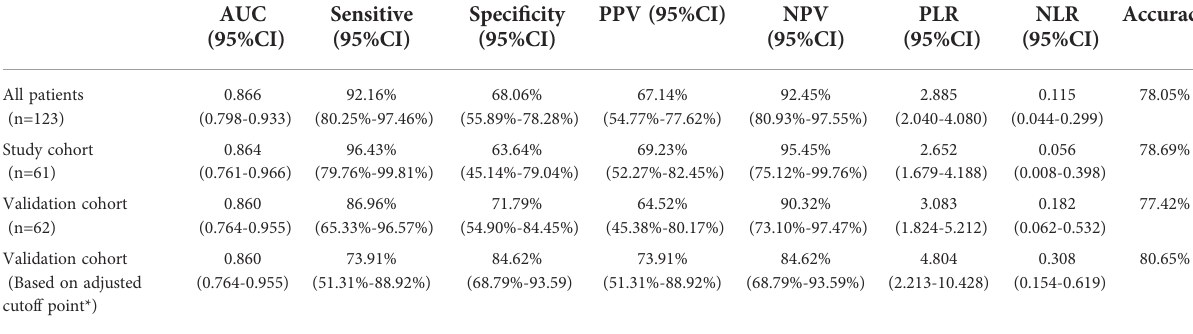
TABLE 2 Diagnosis performance of the QFT-GIT and adjusted